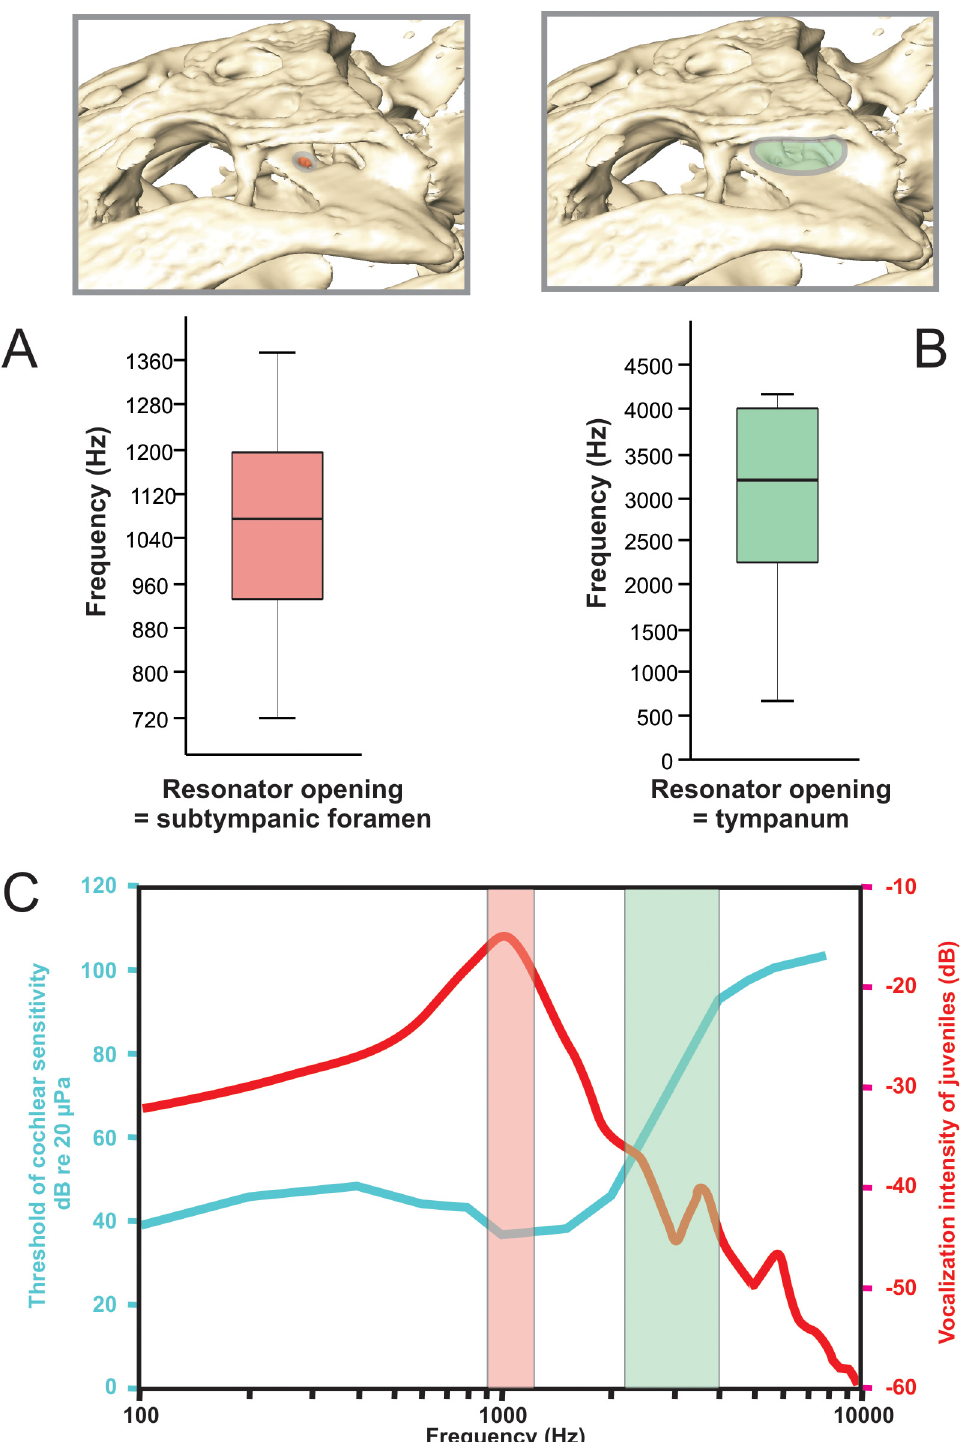
Fig 15. Schematic showing calculated resonant frequencies for A) subtympanic foramen (pink oval) as candidate resonator opening along with plot showing calculated resonant frequencies for an ontogenetic series of alligators. B) tympanic membrane (green oval) as candidate resonator opening along with plot showing calculated resonant frequencies for an ontogenetic series of Alligator. C) Graph adapted from Higgs et al. (2008), showing frequencies of greatest cochlear sensitivity (blue) and juvenile vocalization intensity (red) with the results of the auditory performance analysis superimposed as pink and green bars. Superimposed resonance frequencies show correlation between resonance with the subtympanic foramen to greatest cochlear sensitivity and juvenile vocalization frequencies. doi:10.1371/journal.pone.0137060.g015 PLOS ONE | DOI:10.1371/journal.pone.0137060 September 23,